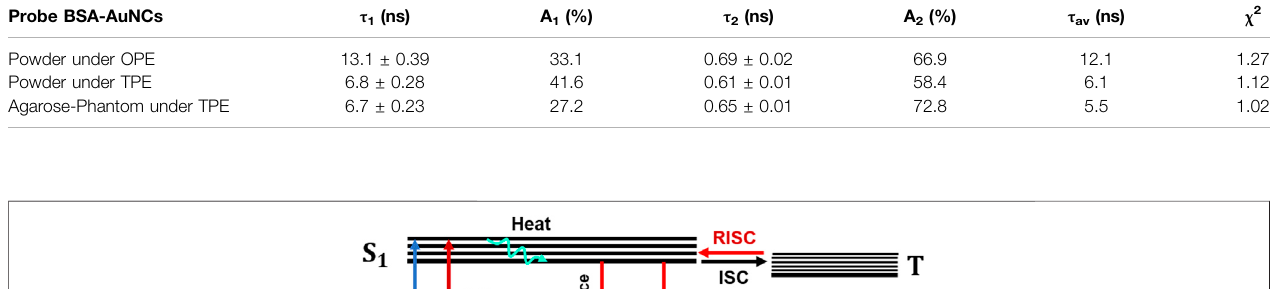
TABLE 1 | The PL lifetime decay parameters obtained for a BSA-AuNCs micro fl ake powder under OPE and TPE. Probe